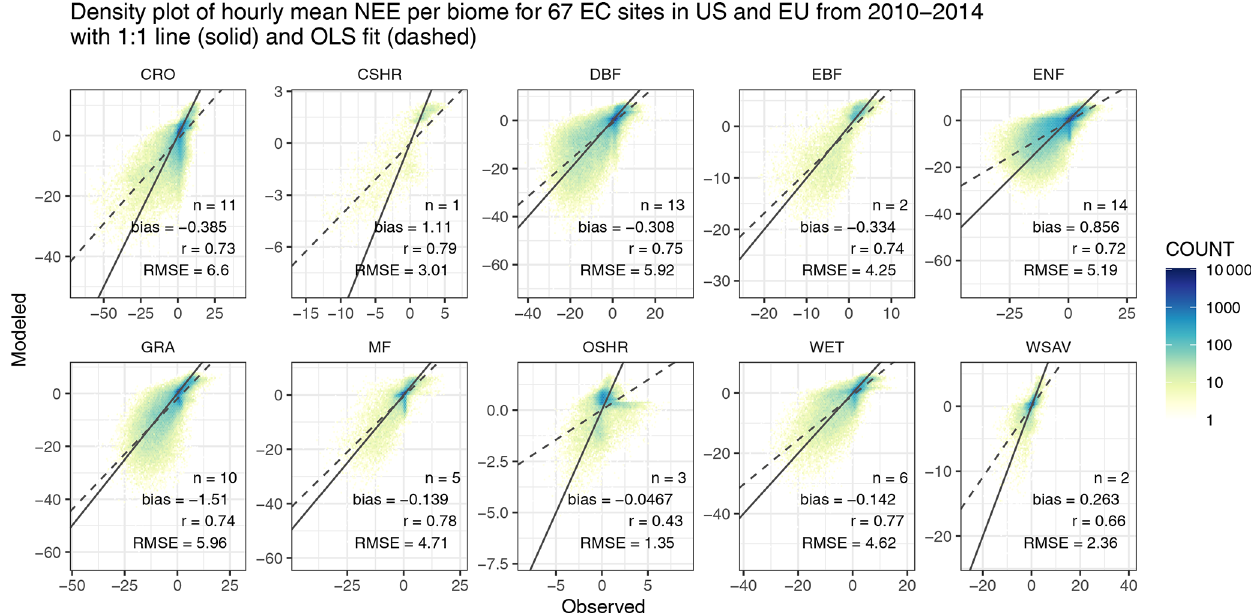
Figure 9. Hourly flux comparisons between modeled NEE and measured NEE from FLUXNET are presented as a density plot for each biome. The number of EC sites per biome ( n ) and several error statistics including the mean bias, correlation coefficient ( r ), and root mean square error (RMSE) are printed in the bottom right corner of each